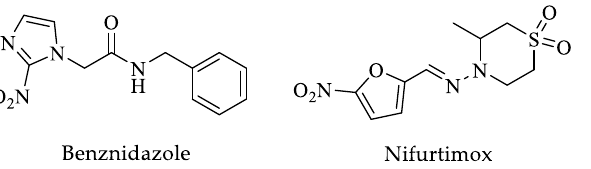
Figure 1. Chemical structures of the two drugs used against Chagas disease. Table 1. Biological activity, dose, and adverse effects of drugs used against Chagas